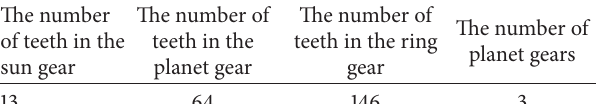
Table 2: Time-domain statistic metrics of the normal and faulty